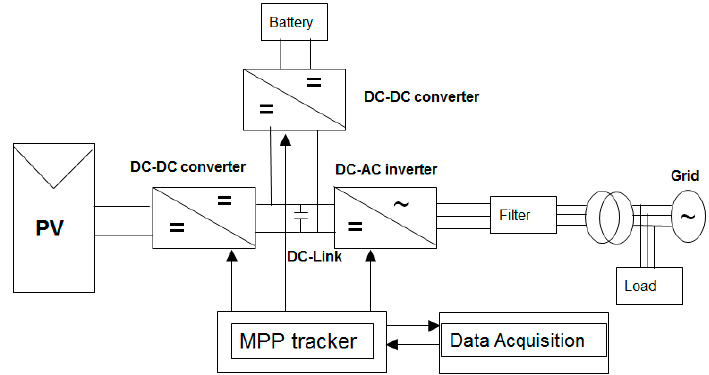
Figure 2. PV system connection to grid and load via DC-DC and DC-AC conversion.